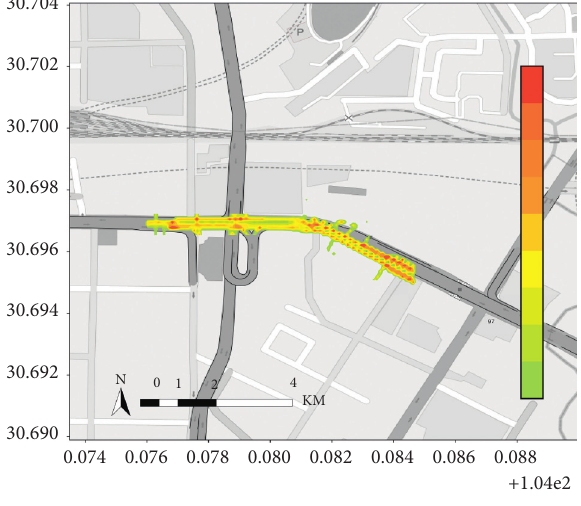
Figure 20: Safety assessment of closed curve section.